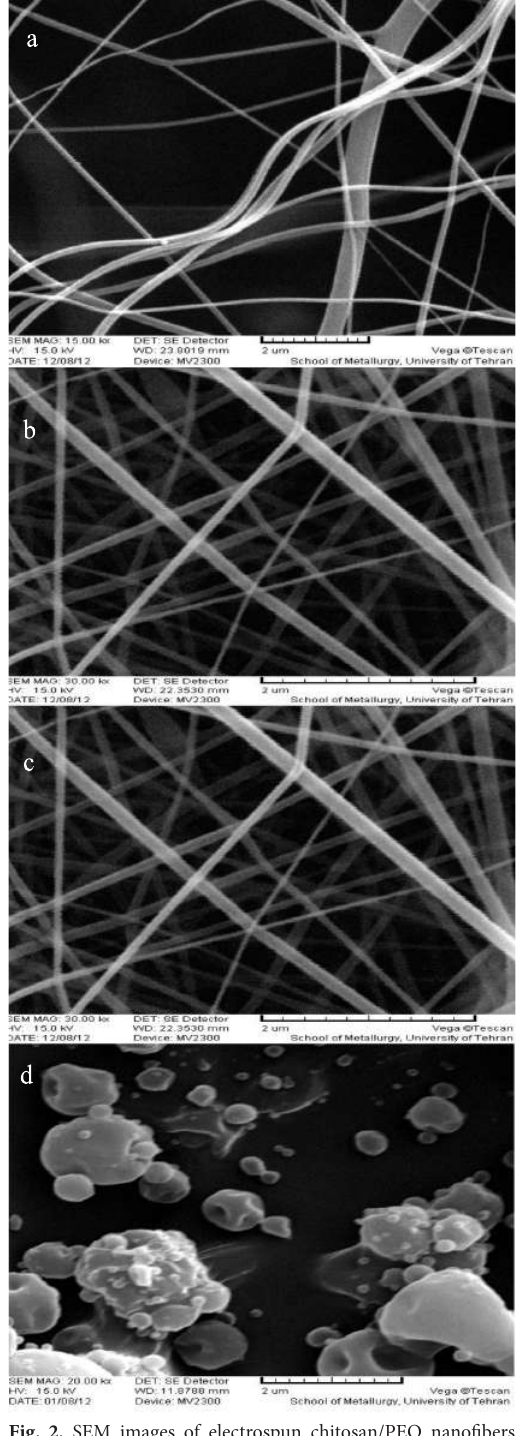
Fig. 2. SEM images of electrospun chitosan/PEO nanofibers containing; a)0.5 b)1 c)2 and d) 3wt% of cefazolin